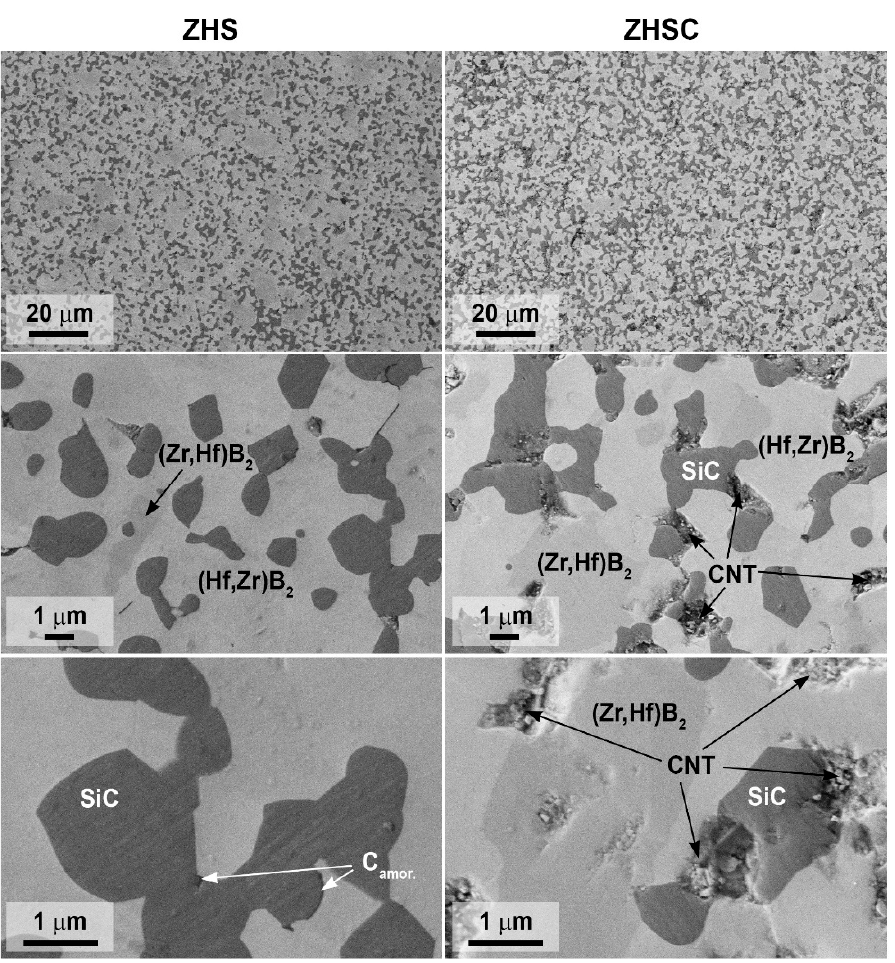
Figure 4. Microstructure of ZHS and ZHSC samples based on SEM data (based on secondary electron detector data), accelerating voltage 2 kV.